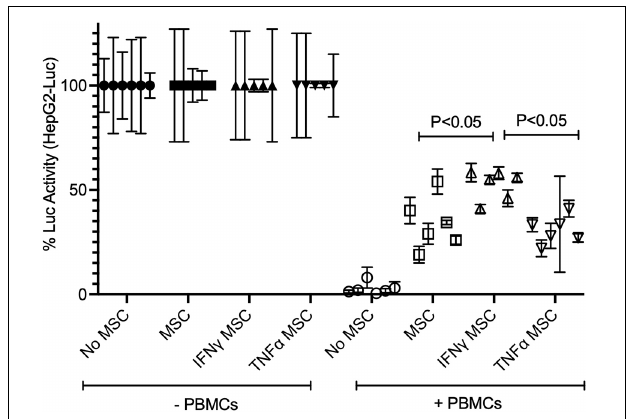
FIGURE 5 | Superiority of IFN γ primed MSCs in protecting HepG2 cells from T cell mediated lysis. HepG2-Luc cells were co-cultured with ± IFN γ or ± TNF α treated MSCs with/without SEB activated PBMCs. Three days later luciferase was measured to detect the survival of HepG2-luciferase cells. Percentage luciferase activity was calculated based on the readouts of HepG2-Luc cells without PBMCs. Protective effects of ± IFN γ /TNF α MSCs on HepG2 cells are shown. Cumulative data with mean and standard deviation derived from six independent MSC donors are shown. Two tailed unpaired t test analysis was performed through prism software to get the p values.